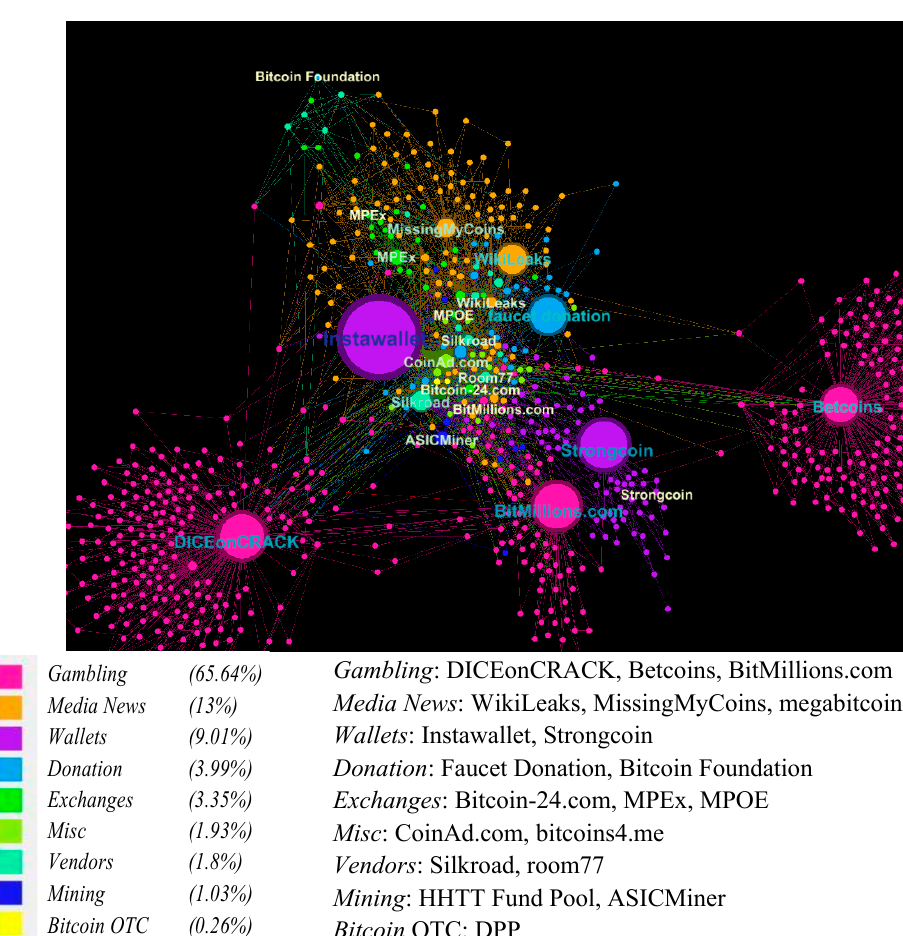
Figure 36. Visualization of Degree Centrality for Important Subgraph.